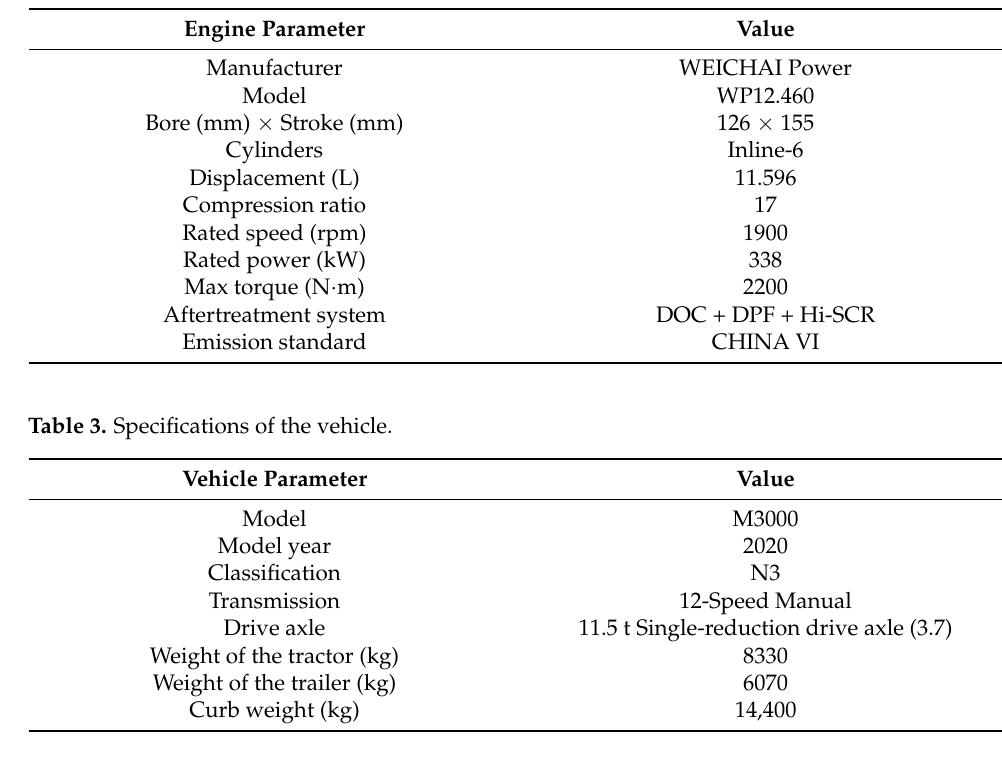
Table 2. Specifications of the engine.